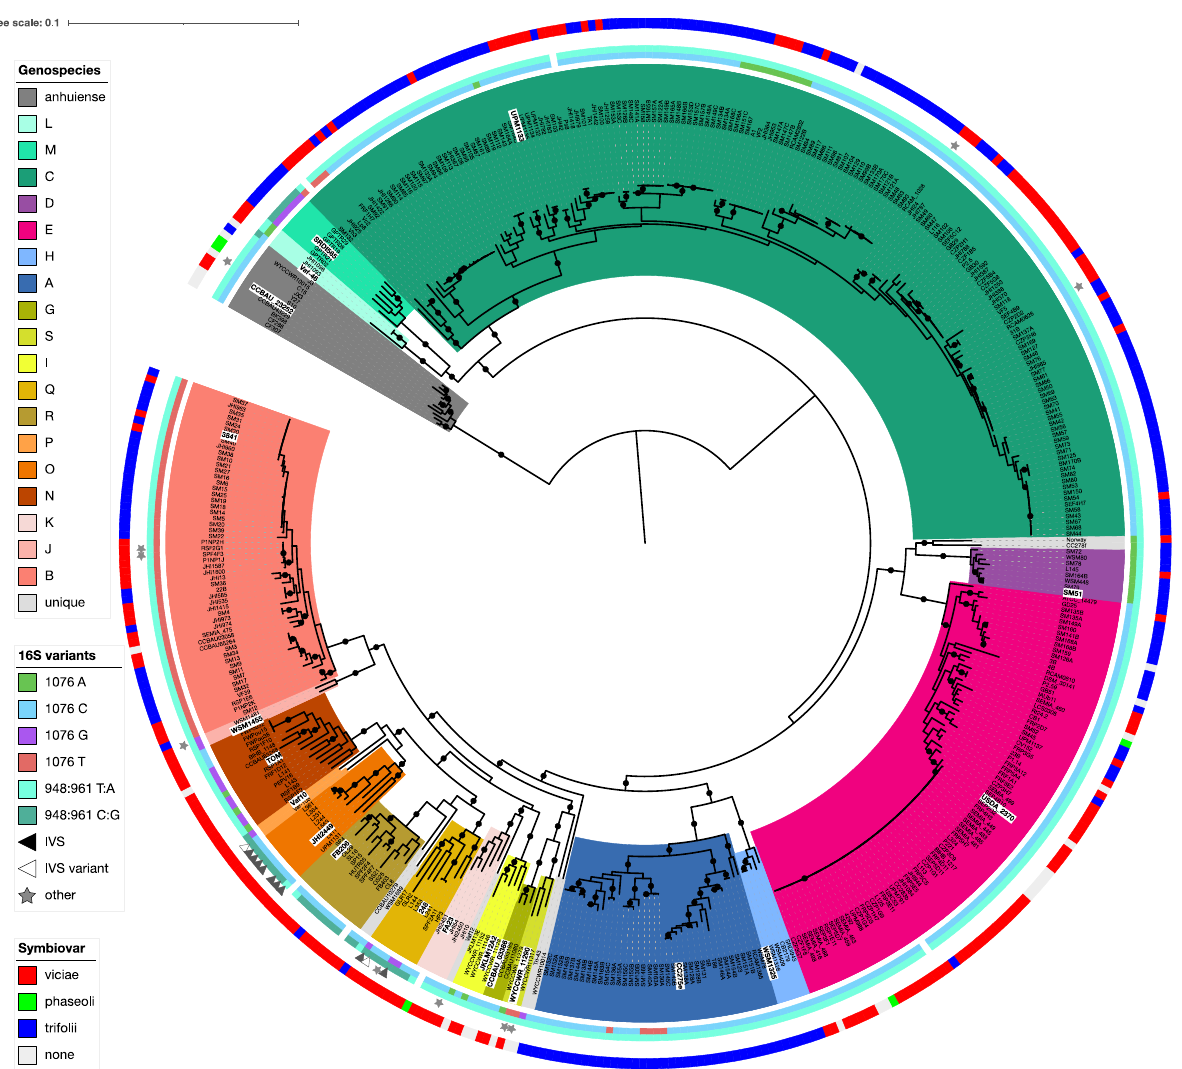
Figure 3. Phylogeny of the Rlc based on 120 core genes. The tree is rooted using R. anhuiense as the outgroup. The 18 potential genospecies are indicated by colored segments. Inner circles and symbols indicate variation in the sequence of the 16S rRNA gene (see text for details). The outer circle indicates the symbiovar inferred from the sequence of Nod genes (if any are present in the assembly). Black dots indicate branches with 100% bootstrap support. The representative strain for each genospecies is highlighted in white. An interactive version is available at https://itol.embl.de/shared/rhizobium.